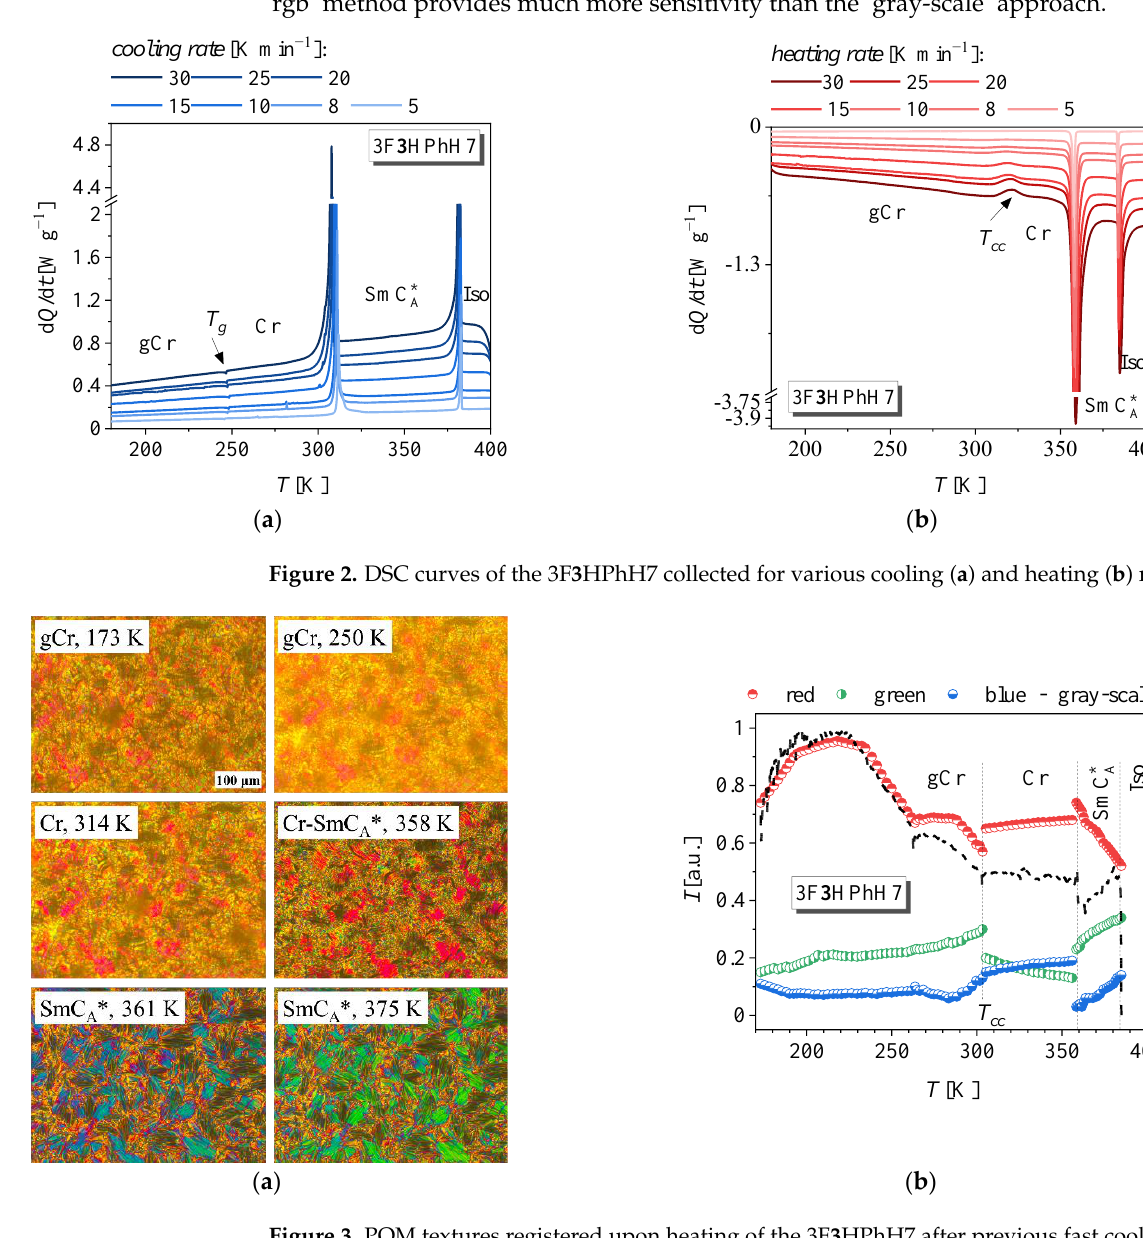
Figure 3. POM textures registered upon heating of the 3F 3 HPhH7 after previous fast cooling ( a ) and the results of the thermooptical analysis of textures collected upon heating ( b ). To confirm the phase behaviour of the 3F 3 HPhH7 compound, the representative textures characteristic for a given thermodynamic state are observed using the polarizing optical microscope (Figure 3a). These POM textures can be interpreted by numerical analysis, using ‘rgb’ and ‘gray - scale’ methods ( Figure 3b); the procedures are described in [18]. The first method is useful when during the phase transitions, the POM textures change in colour. The textures collected at 173 K and 250 K upon heating of the sample